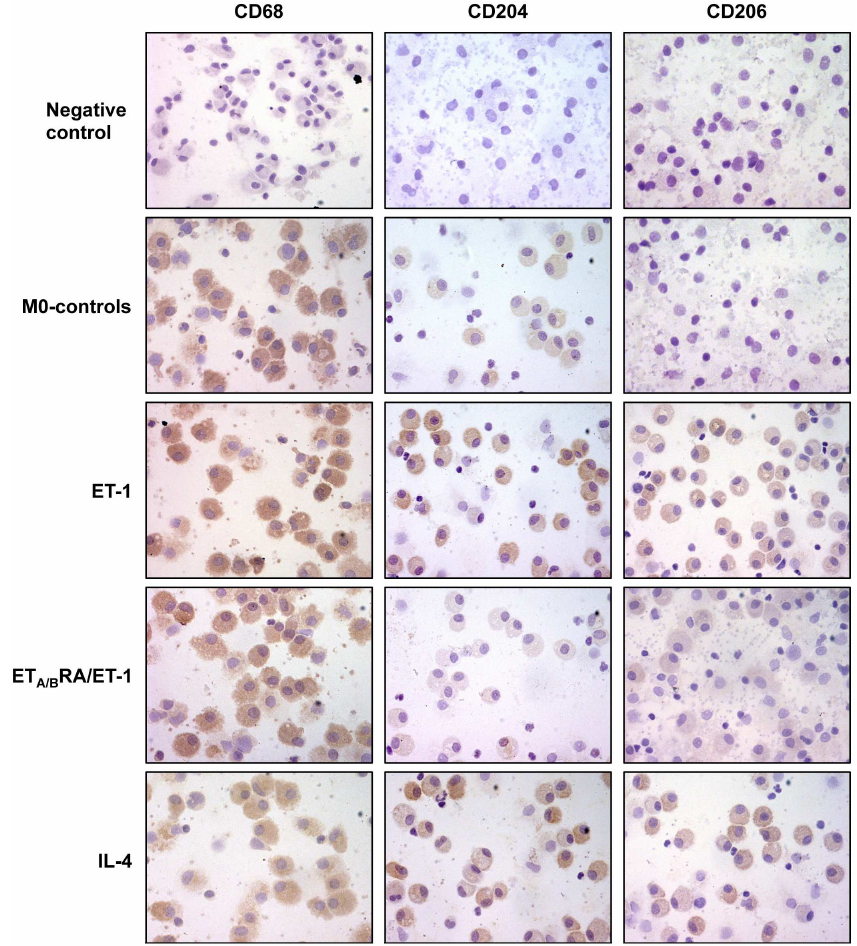
Fig 2. Evaluation of CD68, CD204and CD206expression in cultured human monocyte-derived macrophages. Immunocytochemistry of CD68 (marker of macrophage activation), CD204 and CD206 protein expressionin culturedhuman monocyte-derivedmacrophages treated for 6 days with ET-1 (100nM) and IL-4 (10ng/mL) alone, or pre-treatedwith ET A/B RA (bosentan, 10 -5 M) for 1 hour before being stimulated with ET-1. Culturedhuman monocyte-derivedmacrophages maintained for 6 days in RPMI at 10% of FBS were used as untreatedcells. Immunocytochemistry was performed on four independent in vitro experiments. The detection of protein expression was performed evaluating the same number of cells by light microscopy (magnification